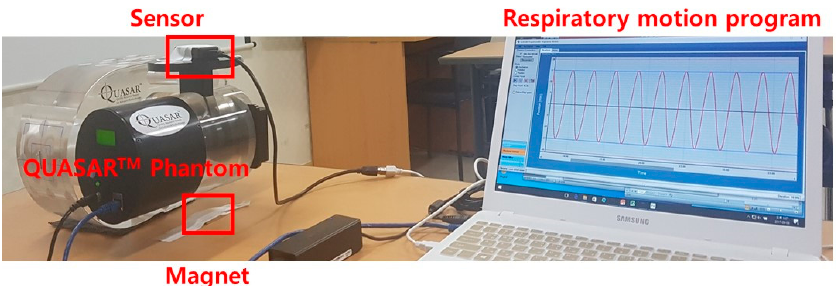
Figure 3. Experimental setup for measuring sensor signals with the QUASAR TM Programmable Respiratory Motion Phantom and respiratory motion program.